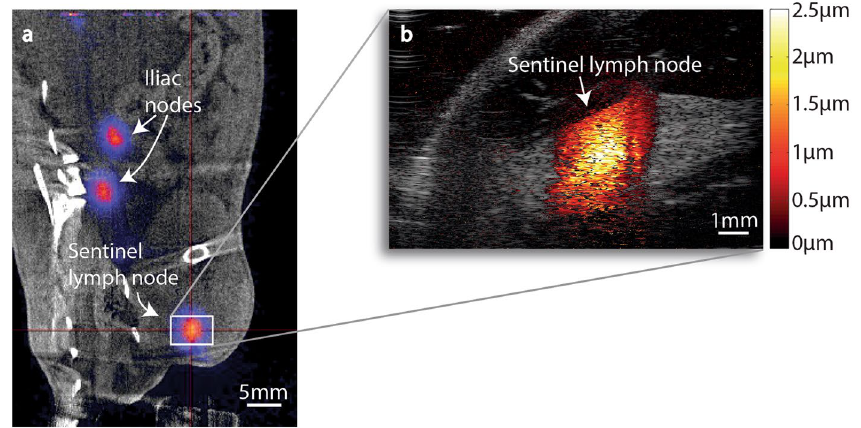
Figure 1. ( a ) Coronal PET/CT image of animal 1. The centre of the red cross shows the position of the nanoparticle-accumulated sentinel lymph node. Nanoparticle accumulation is also seen in two iliac lymph nodes. The lead cylinder shielding the injected paw is shown to the bottom right. ( b ) MMUS image of the same sentinel lymph node. The image is a magnification of the area outlined with a white rectangle in the PET/CT image. The induced magnetomotive displacement is colour-coded in the image according to the colour-bar to the right.